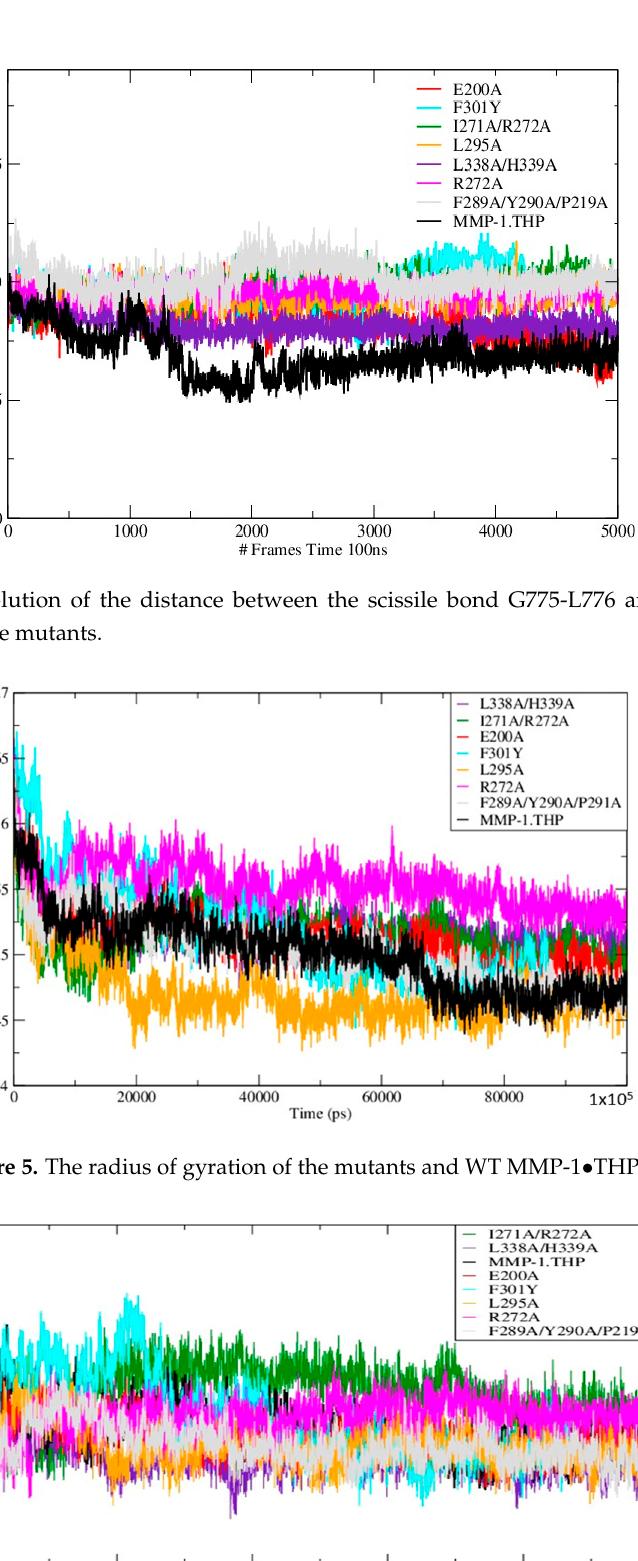
4 of 13 Figure 3. Root Mean Square Fluctuation (RMSF) analysis of linker residues of wild-type (WT) MMP- 1•THP and mutants. RMSF analysis of blade I residue mutants showed relatively higher flexibility of this region for I271A/R272A (Figure S4C and Table S4). The increase in the flexibility of blade I in this mutant with respect to the WT MMP-1•THP could potentially influence THP binding and hence the enzyme activity. Indeed, the I271A/R272A mutation reduced MMP-1 collagenolytic activity [5]. The residues constituting the mutation in blade II showed slightly lower RMSF in comparison to WT MMP-1•THP (Figure S4D). The mutations of residues in blade II (L338A/H339A) resulted in an increase in the enzyme activity [7]. Alteration (decrease or increase) in the flexibility of the linker region would influence the communication between the HPX and CAT domains, binding of the THP, and thus potentially enzyme activity. The specific atomistic mechanism of this effect would need, however, further studies. In addition, strong correlation between the flexibility of residues in blades I and II and the catalytic activity was not extracted from the current data. Mutations can influence not only the local structure, but also regions which are distant from the